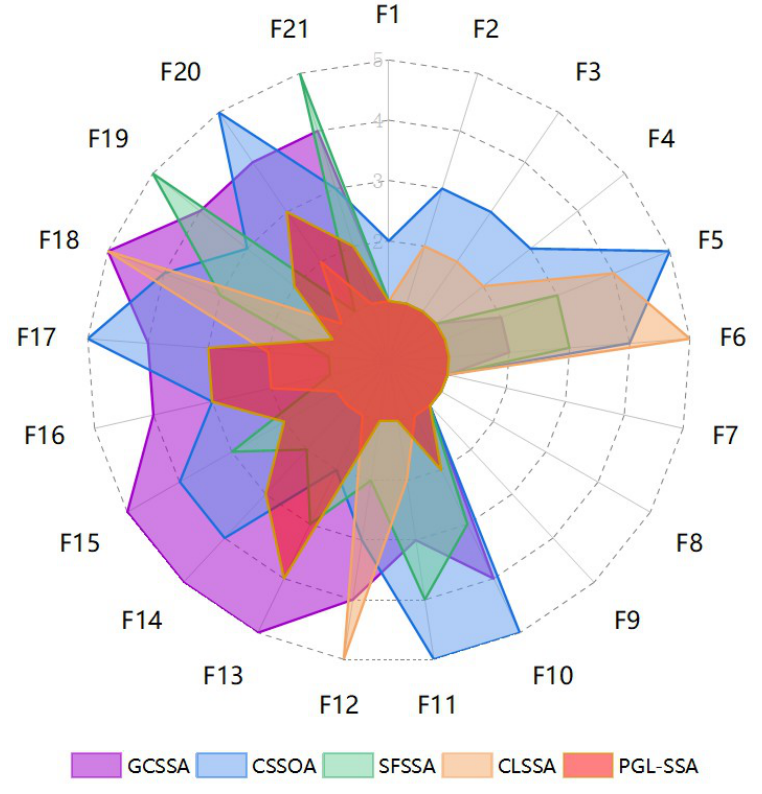
Figure 9. Ranks of the SSA algorithm improved by different